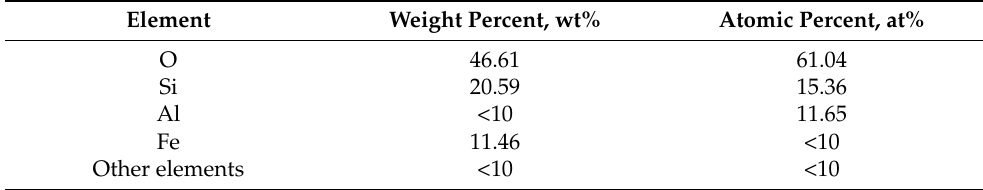
Table 2. Major chemical constituents of cement.